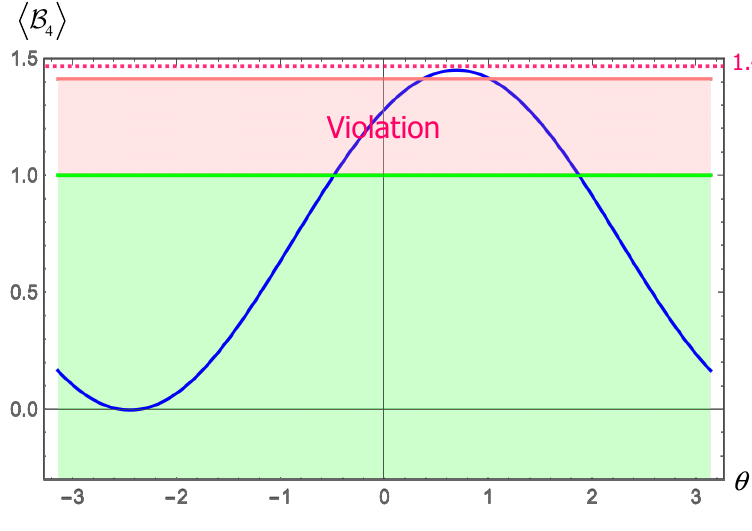
Figure 3. The result of a non-Bunch–Davies